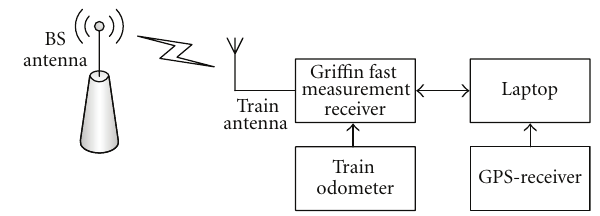
Figure 1: Measurement system.